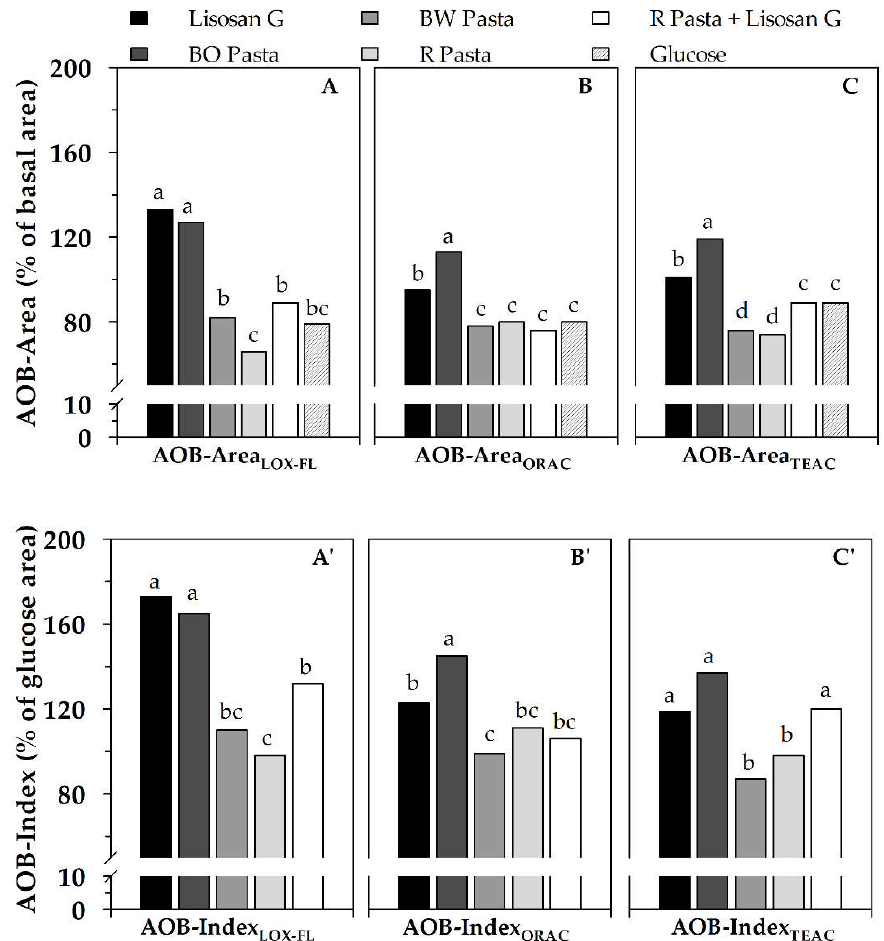
Figure 5. AOB-Area (( A ), ( B ), ( C )) and AOB-Index (( A’ ), ( B’ ), ( C’ )) of serum, evaluated as AC LOX–FL /PxL (AOB LOX–FL ), AC ORAC /PxL (AOB ORAC ) and AC TEAC /PxL (AOB TEAC ) ratios, after consumption of different foods in seven subjects. Serving sizes were 70 g for pastas, 20 g (fresh weight) for Lisosan G and 50 g for glucose. AOB-Area and AOB-Index values of each tested food represent areas under AOB profile vs time (from 0 to 240 min), expressed as (%) of basal area and (%) of area relative to glucose consumption, respectively (see Figure 4). Data are reported as mean value ( n = 7 subjects). Within the same graph, different letters indicate significant differences at p -value equal to 0.05, according to the Duncan’s